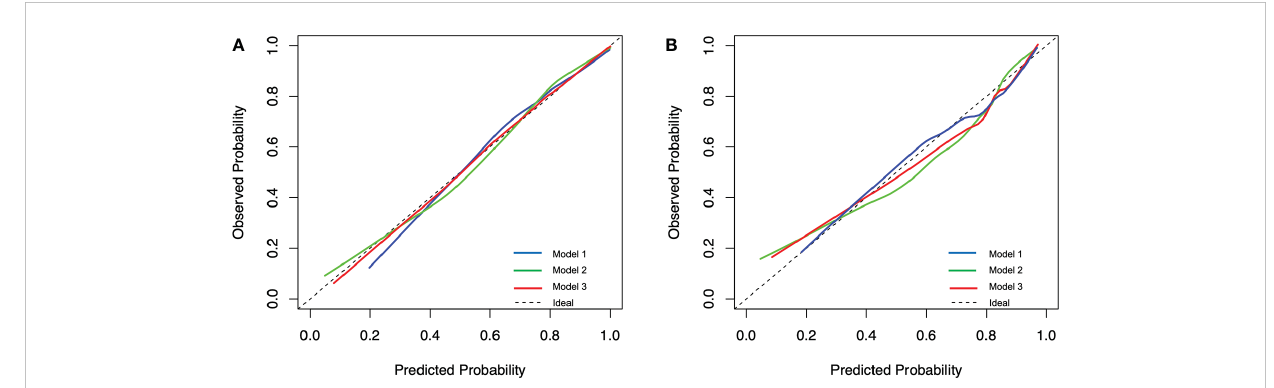
FIGURE 3 Calibration plot of the prediction models for predicting invasive adenocarcinoma lesions from the training cohort (A) and the validation cohort (B) . Model 1, clinical model; Model 2, histogram model; Model 3, integrated